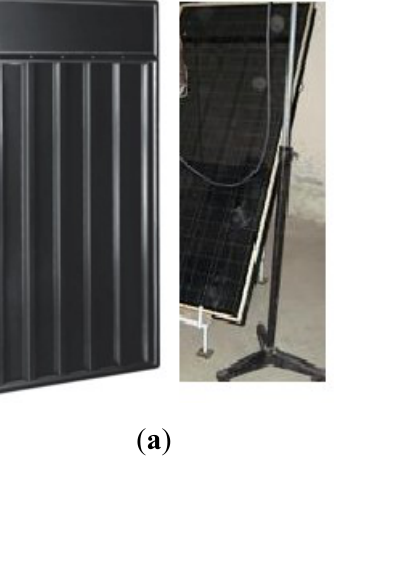
Figure 3. ( a ) Solar collector SH 1500, and system to modify the angle of inclination; ( b ) Optimal inclination angle for Bucharest